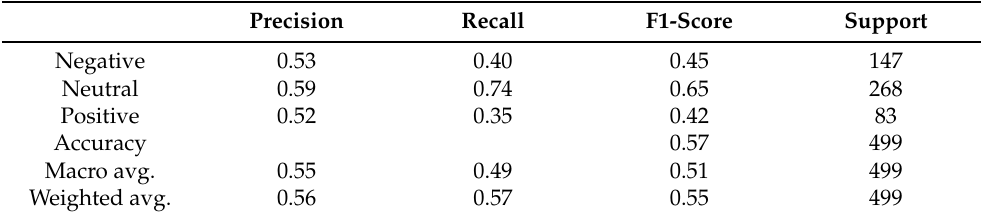
Table 6. Sentiment classifier using VADER. Precision